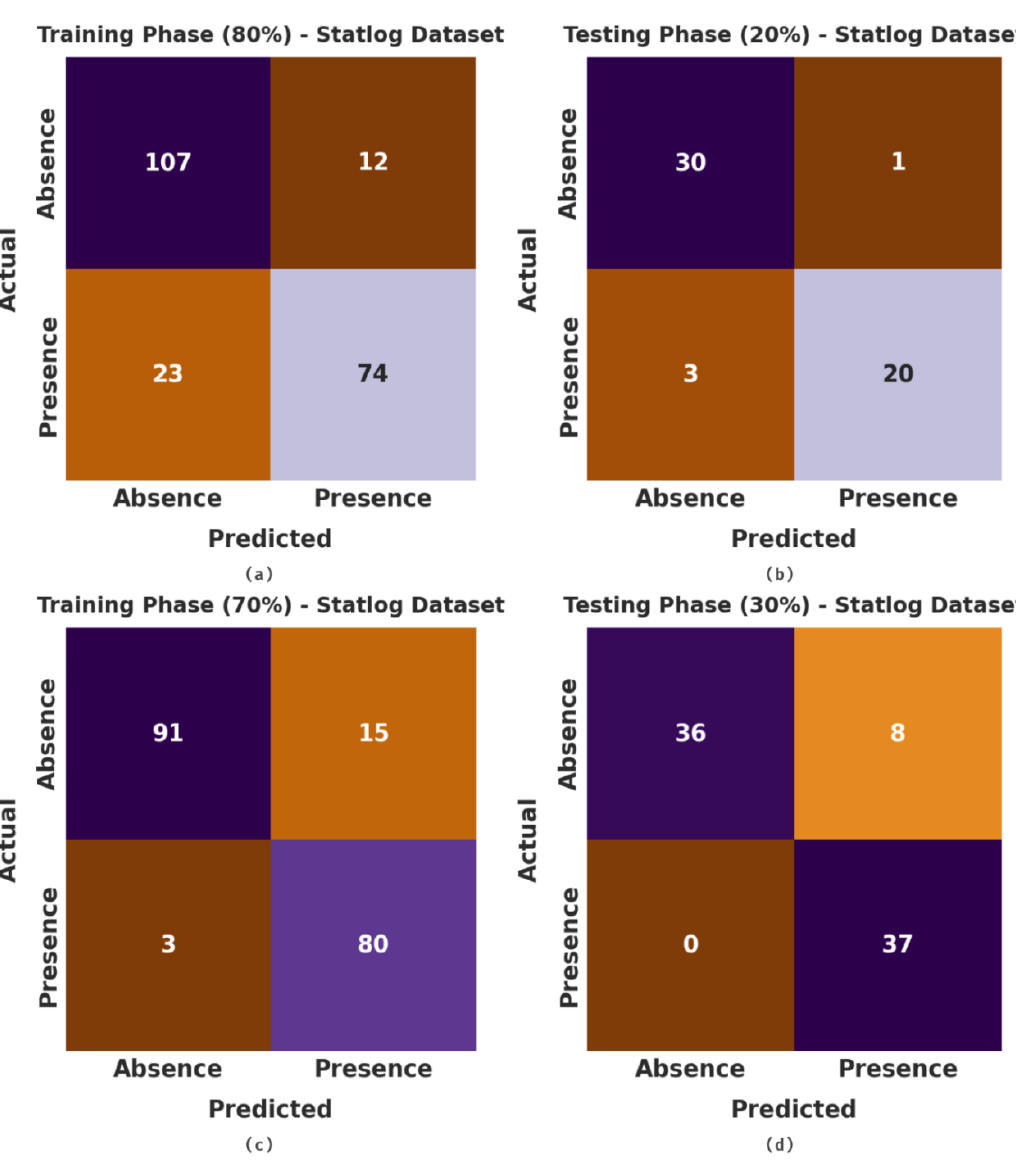
Figure 8. Confusion matrices of MLMDMC-ED method under Statlog dataset ( a , b ) TR and TS database of 80:20 and ( c , d ) TR and TS database of 70:30. Table 3. Analytical results of the MLMDMC-ED algorithm under distinct measures on the Statlog